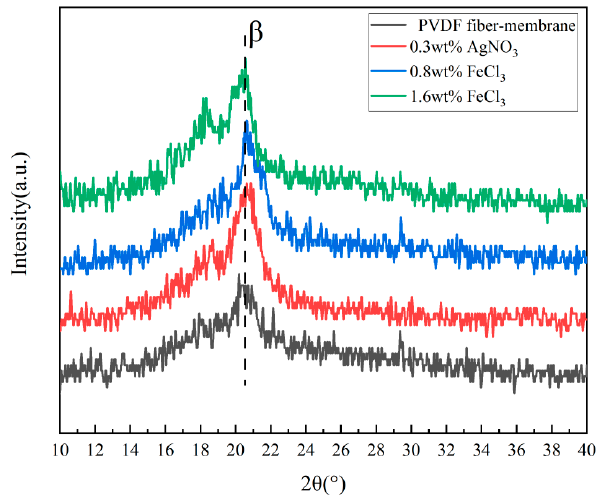
Figure 16. XRD patterns of the P-PVDF fiber membrane, PVDF/AgNO 3 fiber membrane at the addition of 0.3 wt%, PVDF/FeCl 3 ·6H 2 O fiber at the addition of 0.8 wt% and 1.6 wt%.